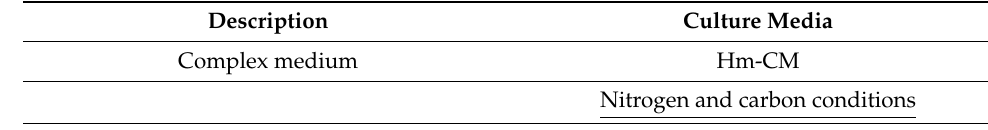
Table 1. Culture media used in the β -galactosidase